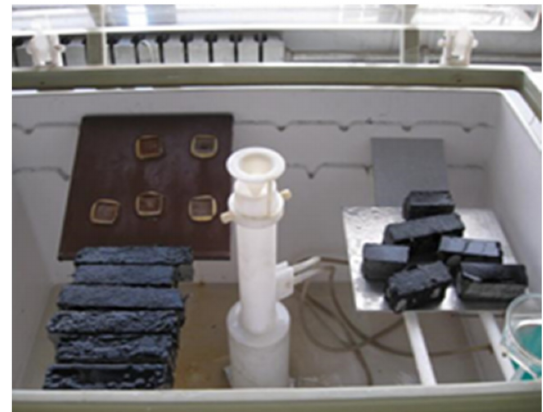
Figure 6. Device for simulating chloride